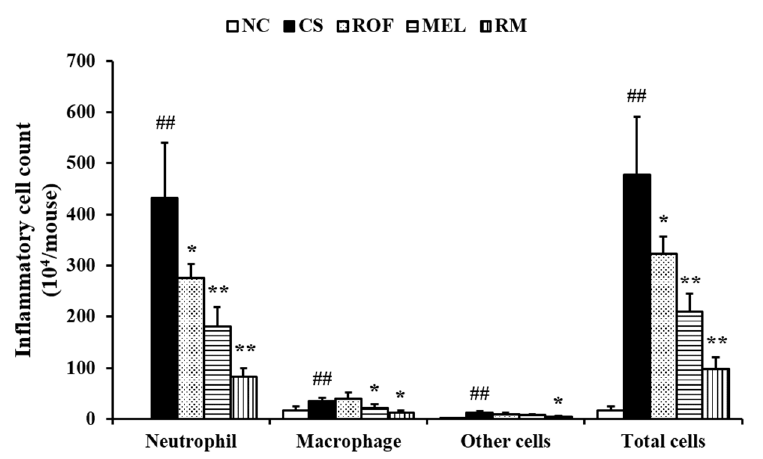
Figure 1. Melatonin decreased inflammatory cell counts in BALF of CS-exposed mice. Cells was determined by Diff-Quik® staining and counted using a light microscope. NC: non-treated and non- exposure group; CS: PBS-treated and CS+LPS exposure group; ROF: roflumilast-treated and CS+LPS exposure group, MEL: melatonin-treated and CS+LPS exposure group, RM: roflumilast and mela- tonin co-treated and CS+LPS exposure group. The data are expressed as mean ± SD (n = 5). ## Signif- icantly different from the NC group, P < 0.01; *,** significantly different from the CS group, P < 0.05 or < 0.01, respectively.